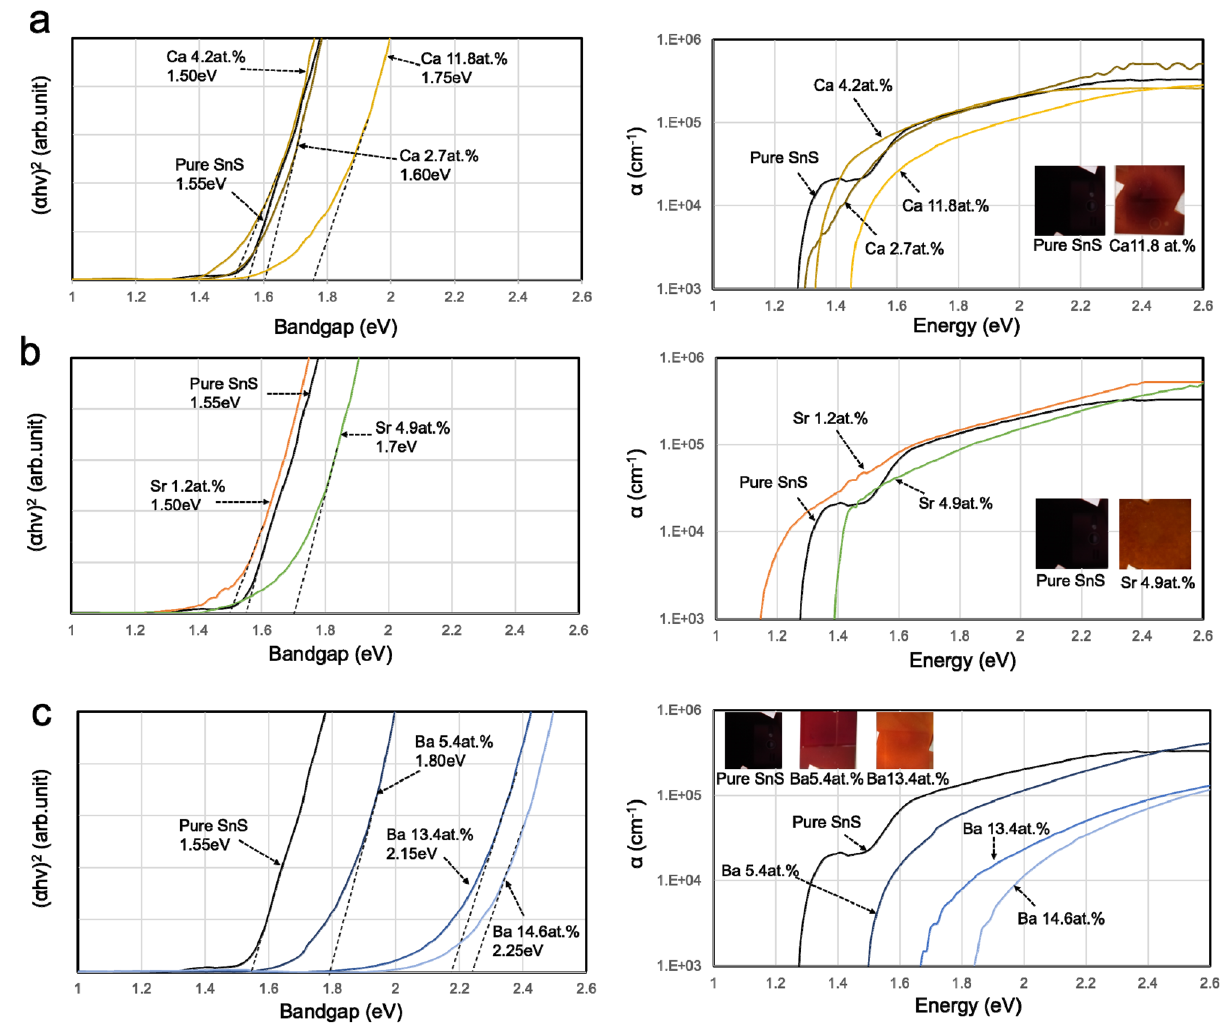
Figure 3. Optical bandgaps estimated by Tauc plots of ( αhν ) 2 (left) and absorption coefficients (right). Results for the ( a ) Ca-, ( b ) Sr-, and ( c ) Ba-alloyed SnS films. Alloying with Ba, which has the largest ionic radius of the A.E. elements except Ra, resulted in a bandgap greater than 2 eV. The insets in the graph show photographs of the films fabricated with and without A.E. element